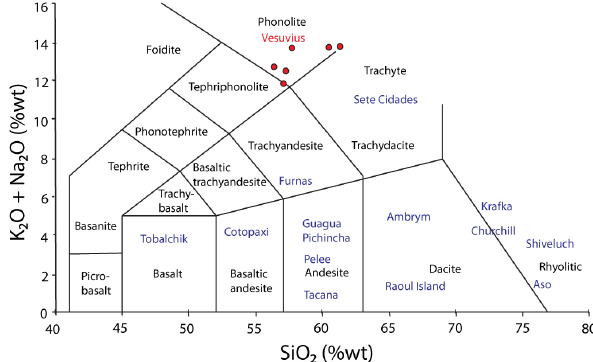
Fig. 4. Geochemical classification of major explosive volcanoes be-